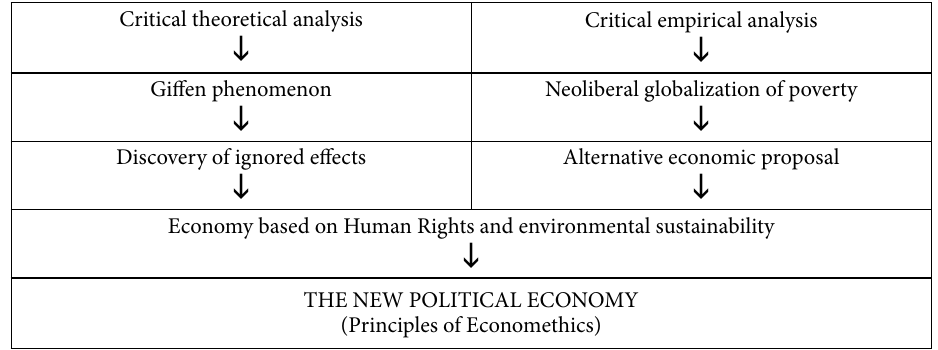
Fig. 4. General scheme for the future development of